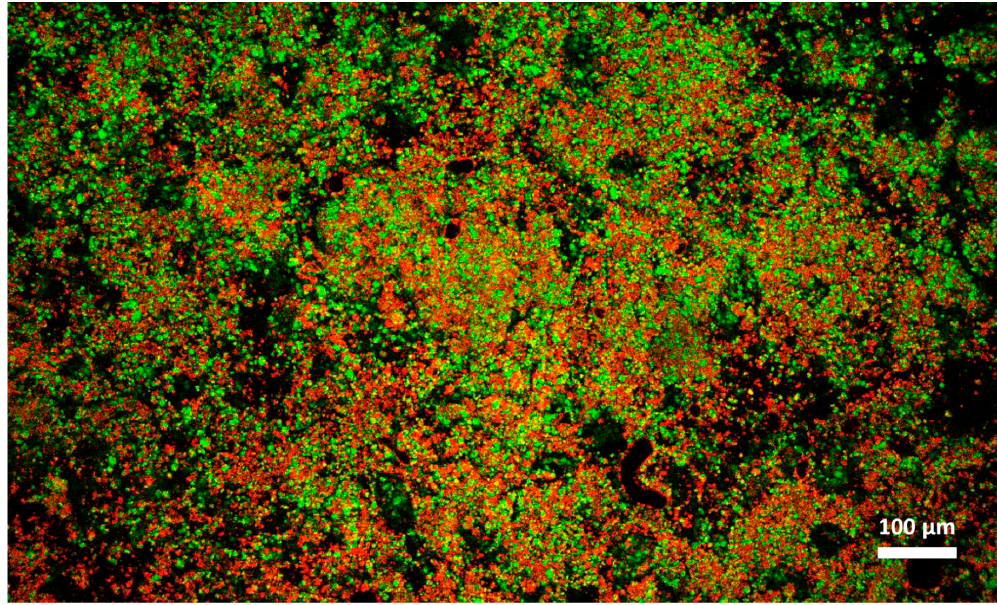
Figure 7. Microstructure of cream cheese B observed with confocal laser scanning microscope after freezing and thawing. Red: fat. Green: protein.